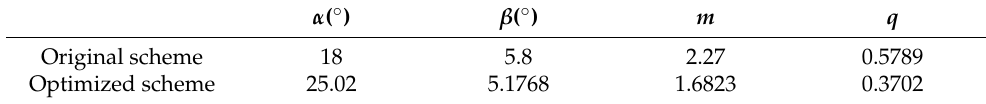
Table 2. Comparison of design parameters between original scheme and optimized scheme.